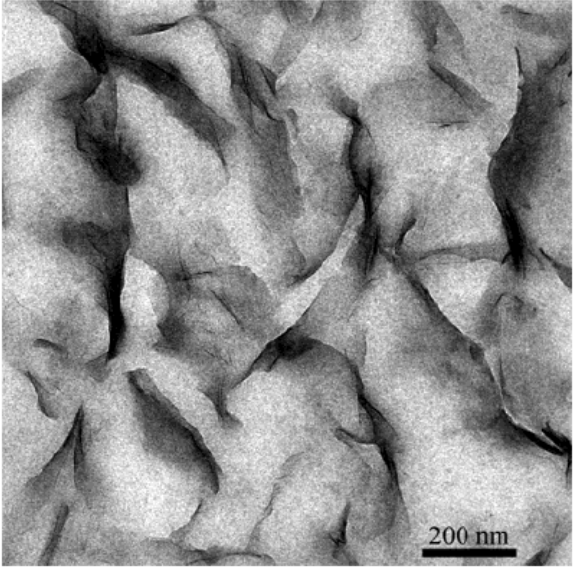
Figure 11. TEM micrograph of the epoxy composite containing 3 vol% of the filler. Reproduced from reference [45] with permission from The American Chemical